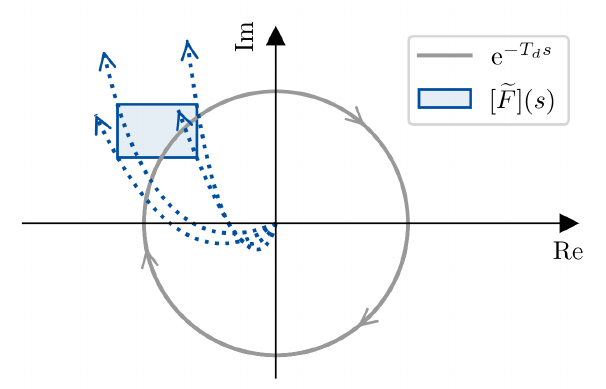
Figure 9. Satche criterion visualized for an interval system where [ (cid:101) F ]( s ) starts in the origin; the blue dotted arrows trace the path of the corners of the rectangular shaped set [ (cid:101) F ]( s ) in the complex